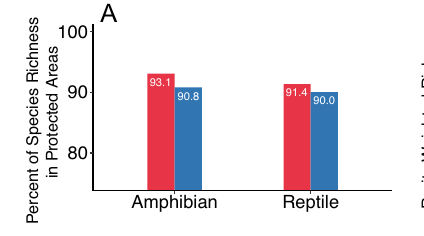
forthecontinentregion;SupplementaryFig.8forallspeciesinallPAs(ClassItoVI) underRCPs2.6,4.5,6.0and8.5.Weassumefuturelanduseremainsunchangedfor this